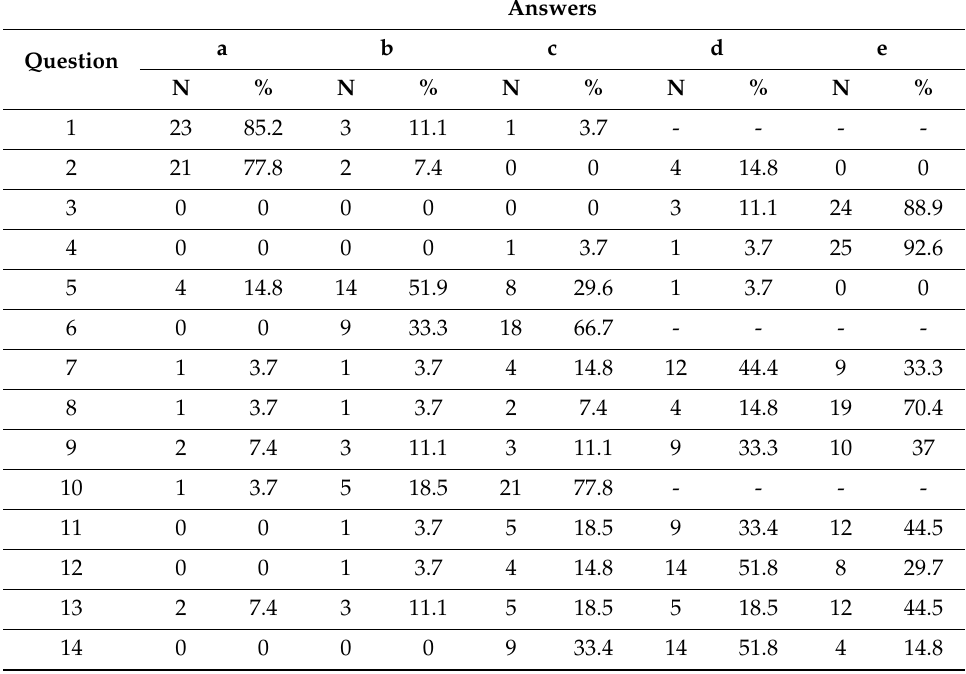
Table 6. Questions proposed in the opinions and satisfaction survey about the students’ knowledge and the